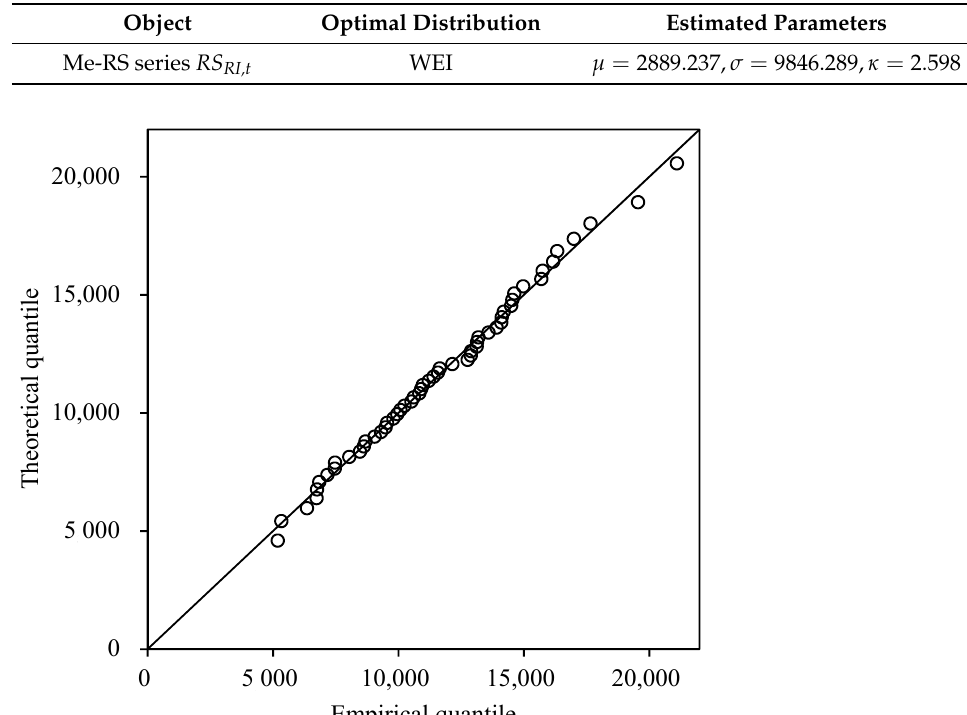
Table 4. Parameter estimation of the optimal distribution for the Me-RS series of the JRB annual runoff.